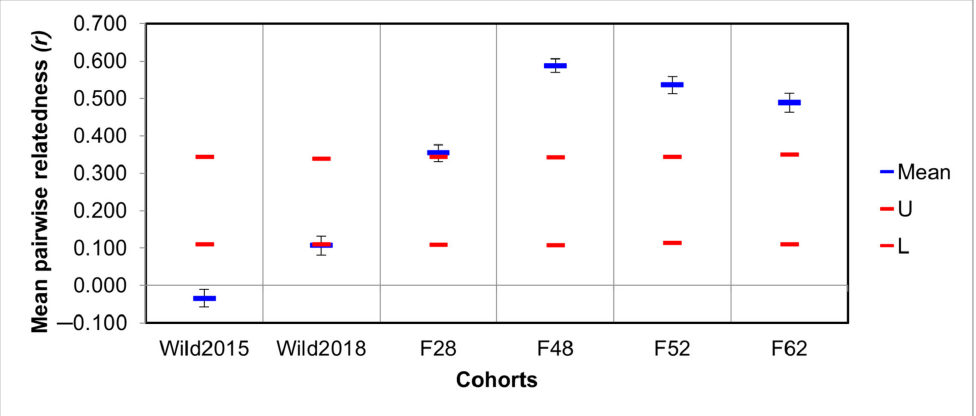
Figure 2. Mean within-population pairwise relatedness estimates, as calculated using the Queller & Goodnight method [67]. Blue bars represent mean relatedness, while red bars indicate the upper and lower 95% confidence intervals for the null- hypothesis of no significant differences in mean relatedness amongst groups. Error bars indicate the standard error for each mean.